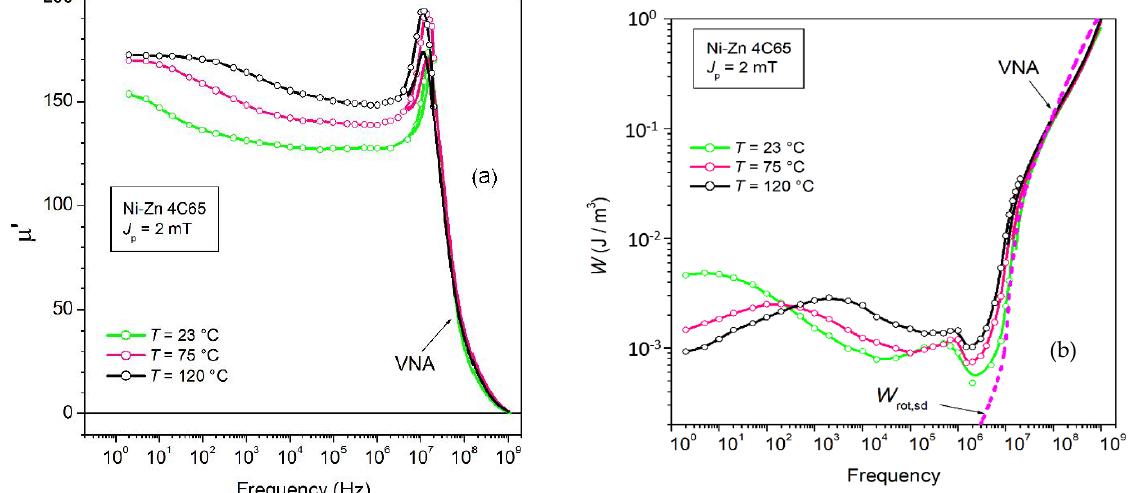
Figure 18. The dw relaxation effect associated with the interaction of changing magnetization with diffusing atomic species (diffusion aftereffect) is found to be associated with an activation energy of 0.66 eV. We accordingly observe the cutoff frequency of µ (cid:48) ( f ) ( a ) and the related low-frequency peak of W ( f ) ( b ) to drift toward higher frequencies upon increasing temperatures. A secondary peak, appearing at all temperatures around 800 kHz, could be related to dw resonance. The predicted rotational loss W rot,sd (Equation (29)) shows that the resonant absorption of energy by the precessing spins in the bulk drifts towards 10 MHz and